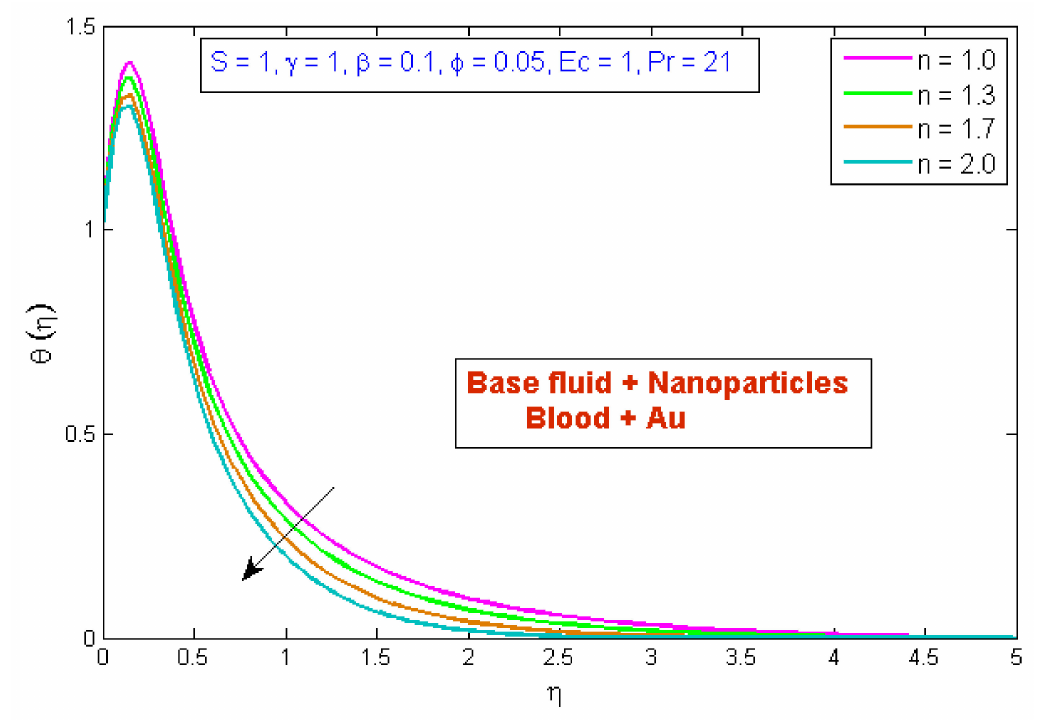
Figure 8. Modification of θ ( η ) versus n .